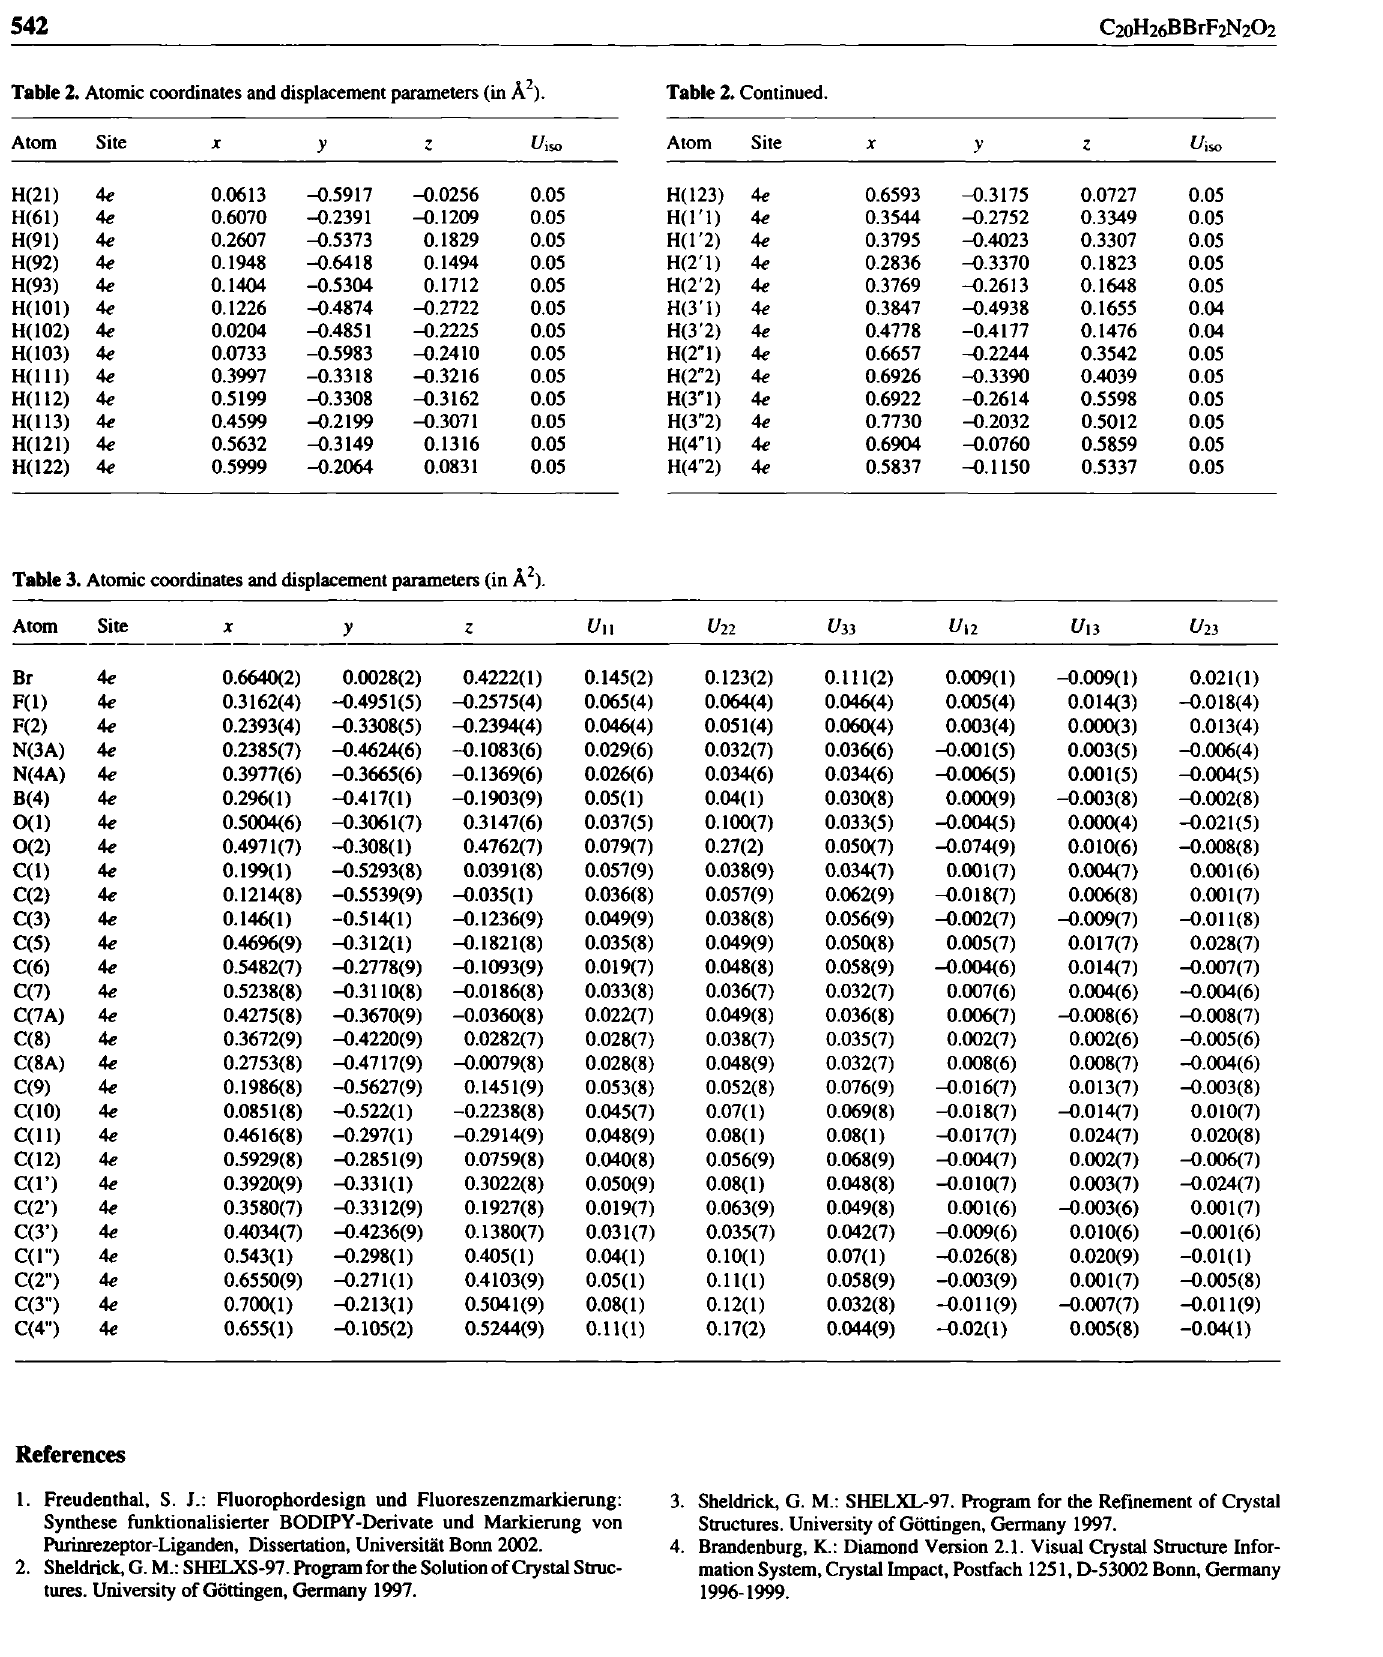
Table 2. Atomic coordinates and displacement parameters (in À 2 ).